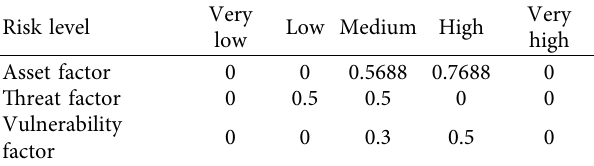
Table 5: Fuzzy matrix of each assessment factor.